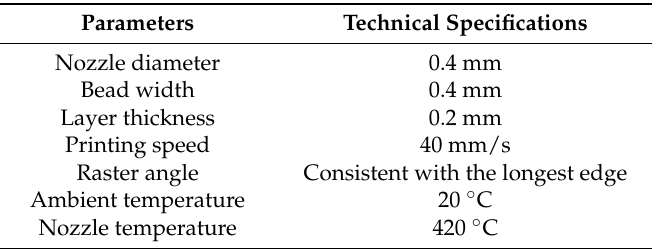
Table 2. Technical specifications of the FDM printer.